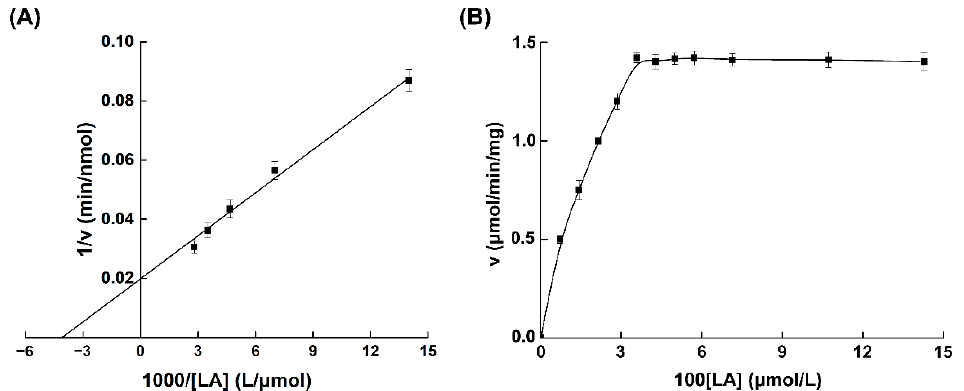
Figure 8. Substrate reaction kinetics of MBP-PAI: ( A ) Lineweaver–Burk plot of MBP-PAI for LA; ( B ) reaction velocity of MBP-PAI at different LA